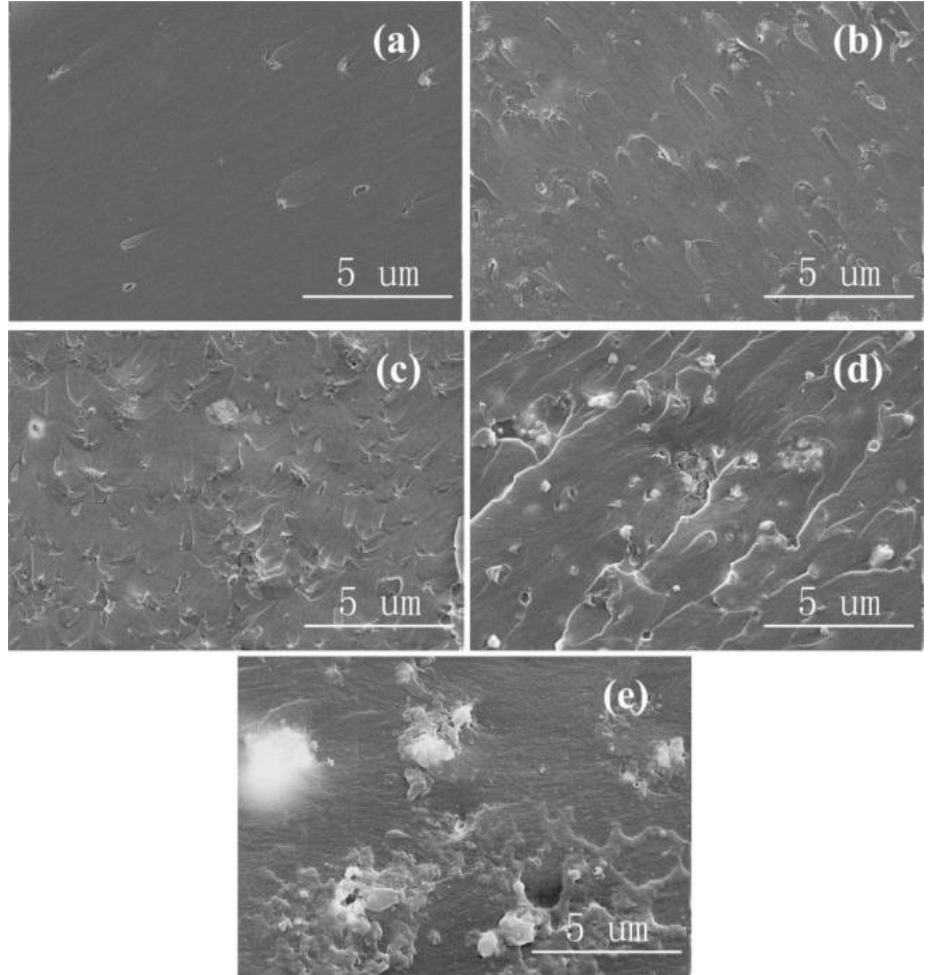
Figure 3. SEM images of Al 2 O 3 -NWs/epoxy resin composites with ( a ) 1 wt.%, ( b ) 3 wt.%, ( c ) 5 wt.%, ( d ) 7 wt.%, and ( e ) 10 wt.% of Al 2 O 3 filler.